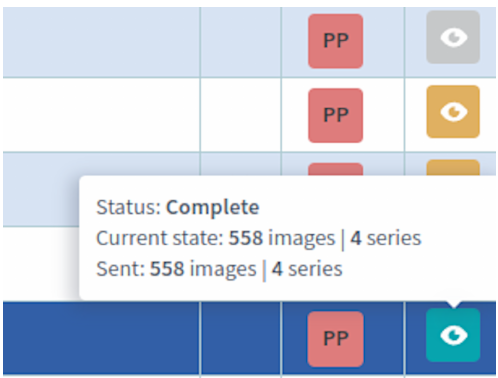
Figure 4. Internal queue state and priority visualization (partial screenshot). Green status is assigned to studies fully available in Central PACS, orange to studies during transfer, and gray marks for cases waiting for transfer. PP denotes the highest